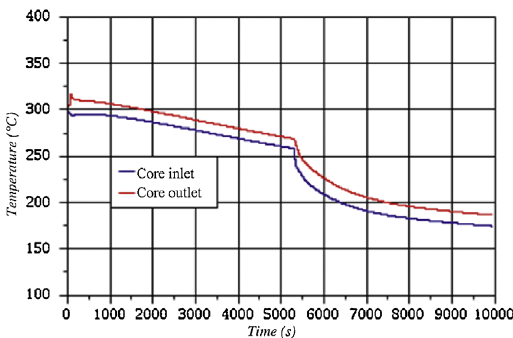
Fig. 13. Primary temperature ( °